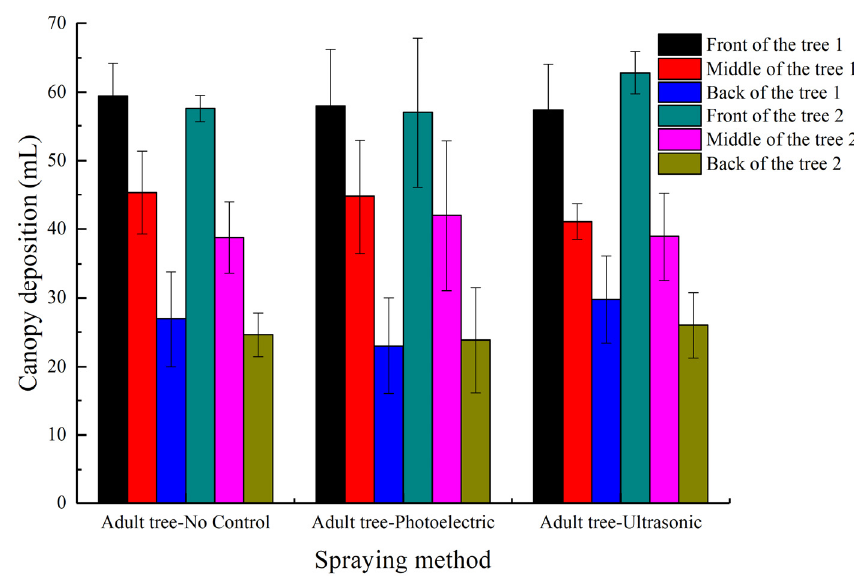
Figure 15. Canopy deposition distribution among the adult apple trees.